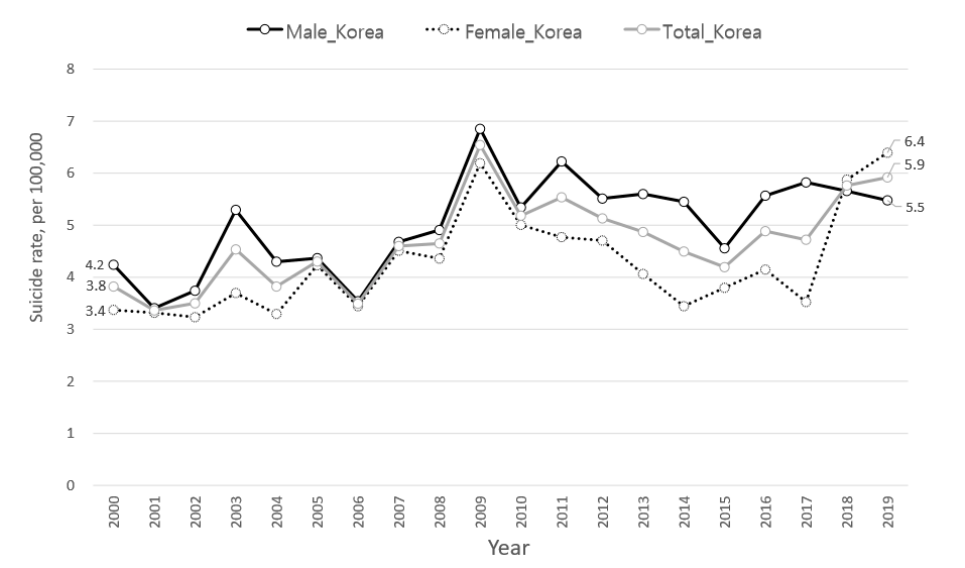
Figure 1. Trend of suicide rates among 10–19 years old in South Korea.